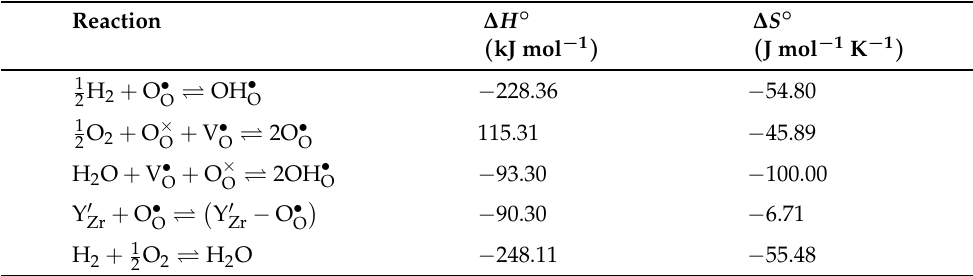
Table 1. Enthalpy and entropy of defect incorporation reactions in BZY20. Reproduced with permission from Zhu et al. [4]. Copyright The Electrochemical Society,